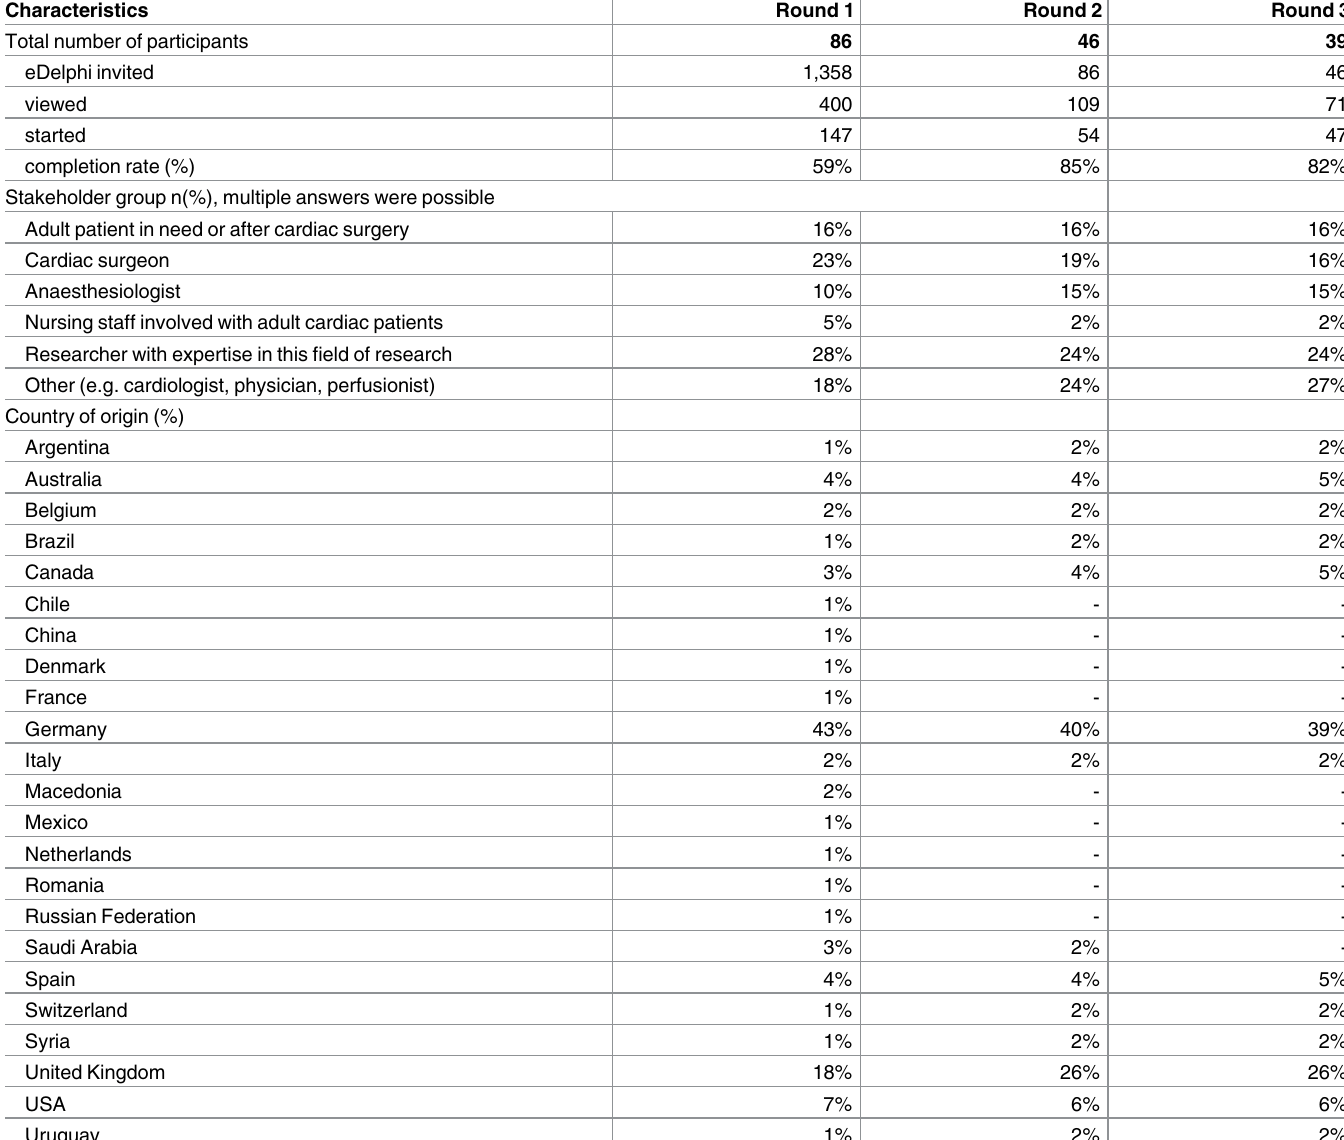
Table 1. Characteristics of